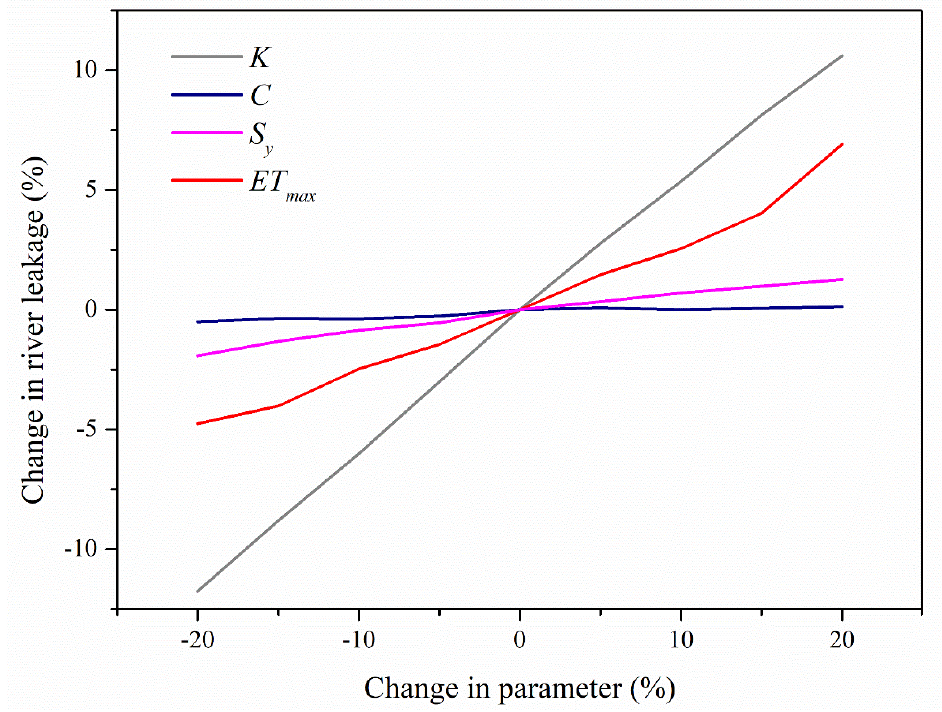
Figure 6. Sensitivity of river leakage to the model parameters.